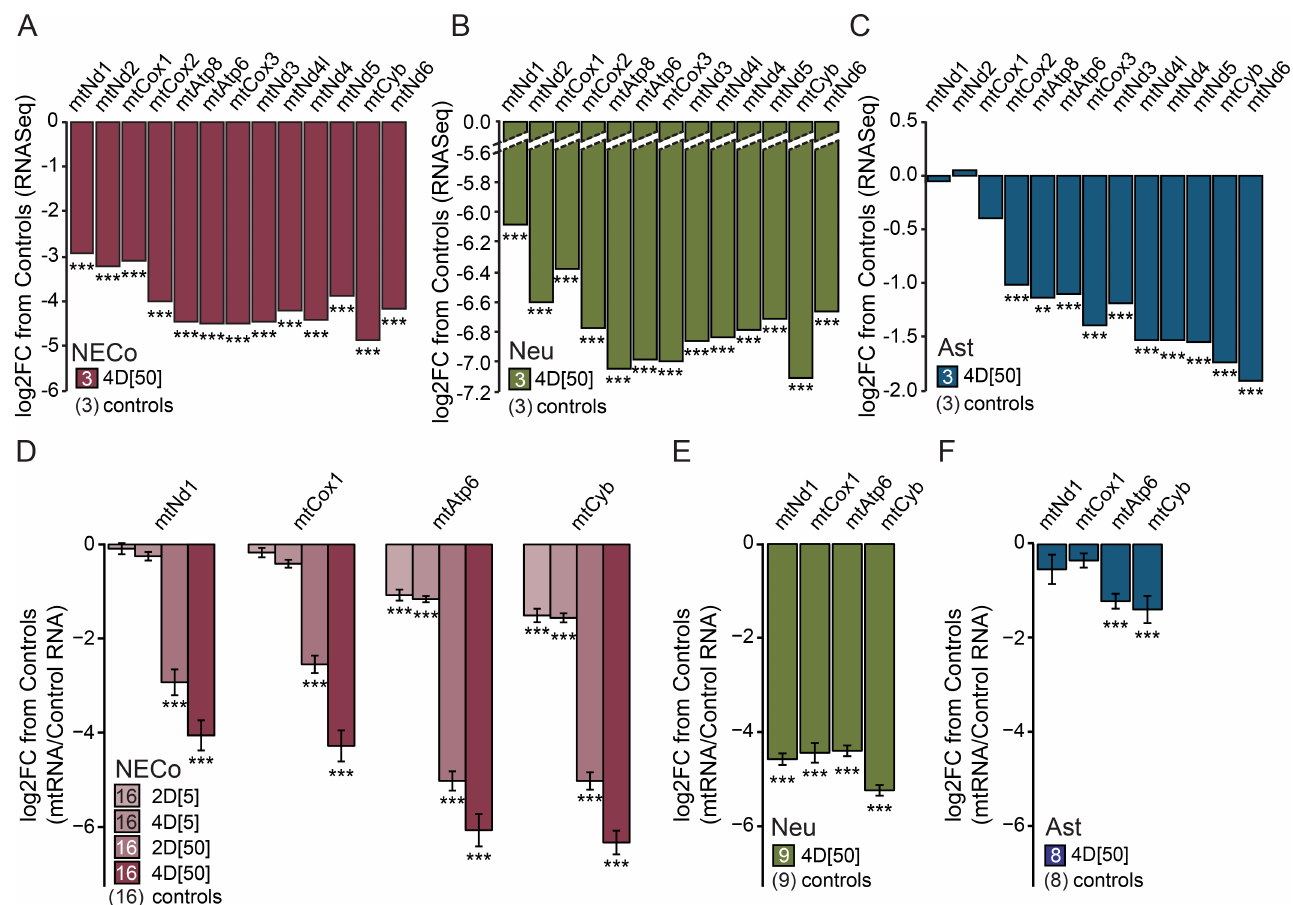
Fig 3. Exposure to EtBr decreasesmtRNA in rat striatal co-cultures, purified neuronal cultures, and astrocytes. (A-C) Log2-folddecrease in mtRNA expressionafter EtBr treatment assayed with RNASeq,in (A) NECos, (B), pure neuronalcultures, and (C) astrocytes. Each bar is a comparisonof three control samples to three EtBr-treated samples, each pooledfrom two independently dissected culture experiments. MultiRankSeqanalysiswith false discovery rate–adjusted p-values taken from the DESeq comparison. mtRNAs were the most significantly changed RNA transcripts in neuronswith a p-value of 0. (D-F) Log2-folddecreasein mtRNA expressionafter EtBr treatment assayed with qPCR. Error bars reflect delta-method propagated+/-SEM, with level of significancedeterminedfollowingDunn’spost-hoc test. 2D[5] = 5ng/ml EtBr for 2 days, 4D[5] = 5ng/ml EtBr for 4 days, 2D[50]= 50ng/ml EtBr for 2 days, 4D[50]= 50ng/ml EtBr for 4 days. N for each group is includedin figure legends. *** = p < 0.001, ** = p < 0.01, relative to controls. Transcripts are arrangedaccordingto their distance from HSP2 (see Fig 1A). The ND6 gene, the only mRNA on the light chain, is shown